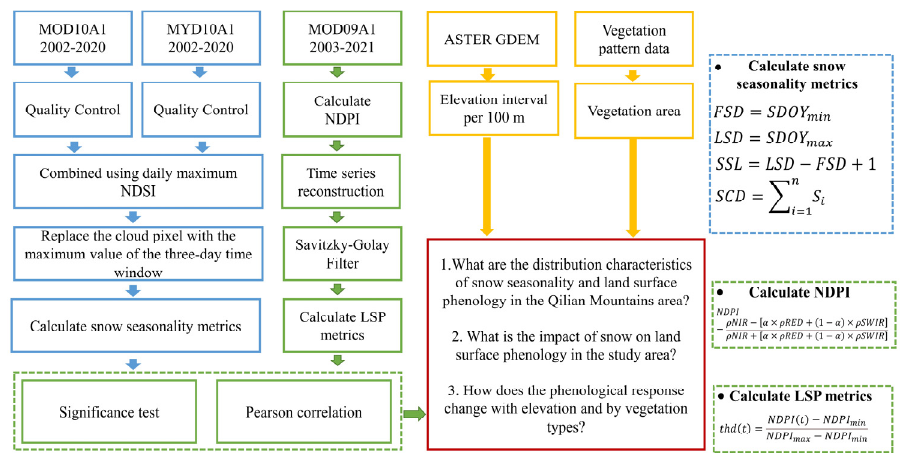
Figure 3. Overview of technical workflows.